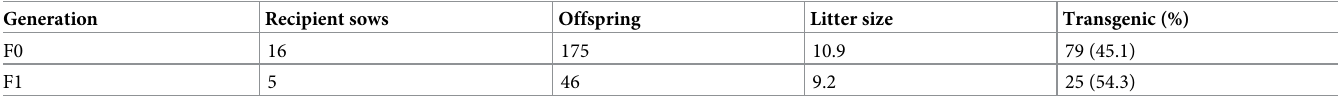
Table 4. Analyses of transgenic gene transfer in pigs.